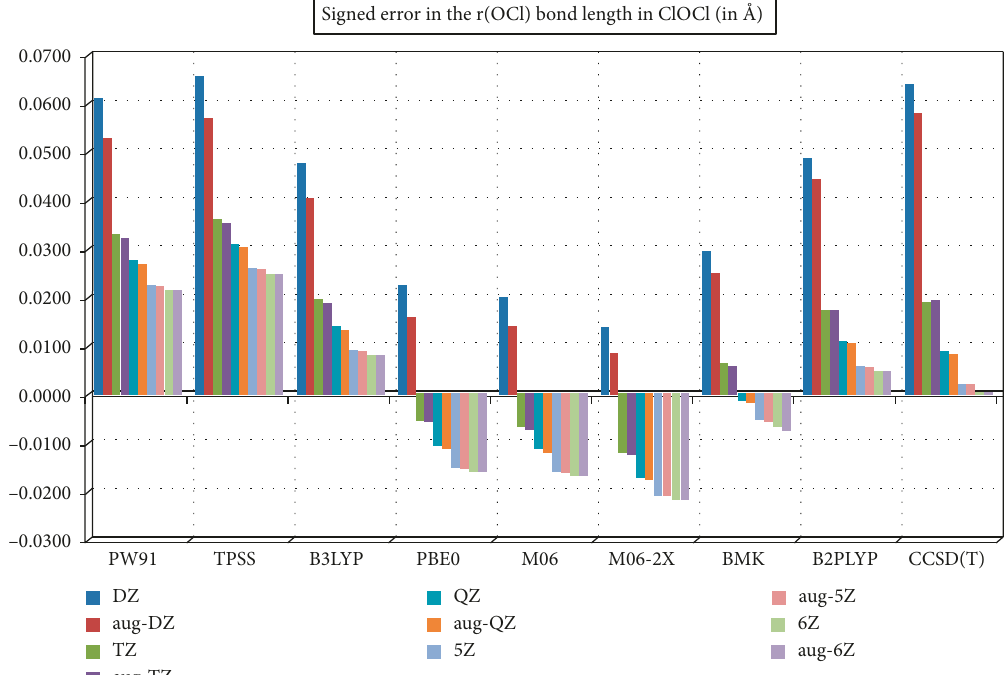
Figure 9: Signed error of the calculated r (ClO) bond length with respect to the experimental value (in ˚A) for each level of